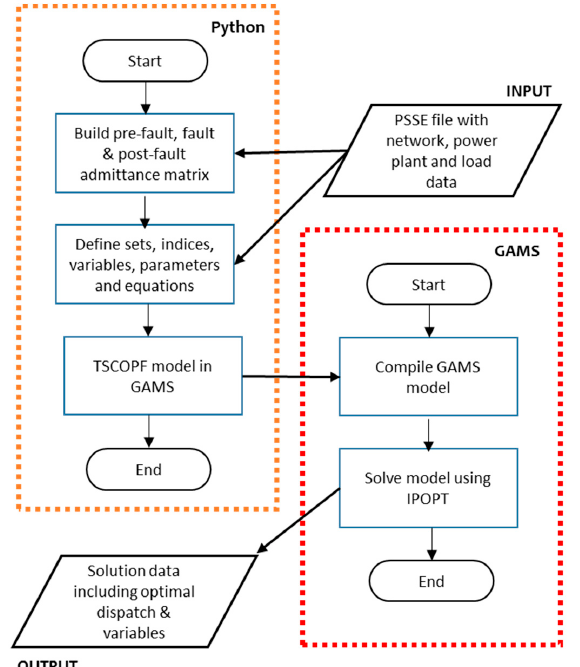
Figure 1. Software implementation for TSCOPF. Energies 2019 , 11 , x FOR PEER REVIEW